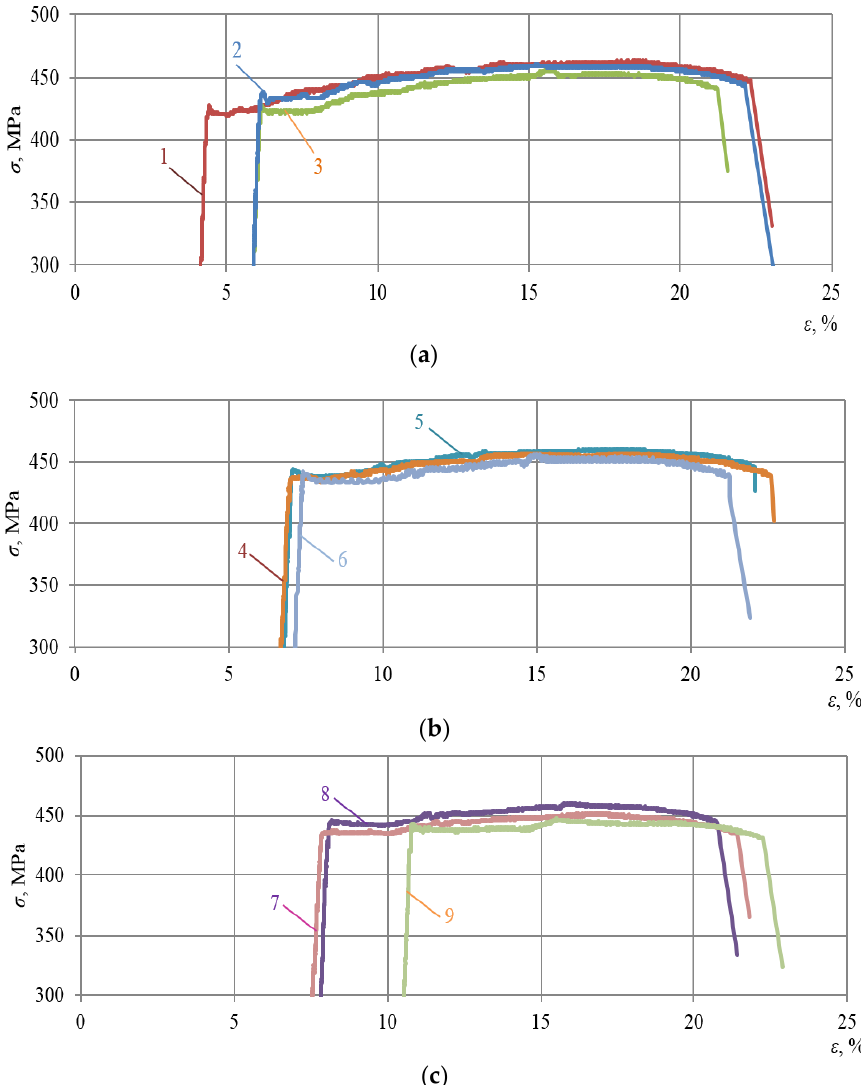
Figure 4. Deformation diagrams of the 2024-T351 alloy during static stretching after DNP of differ-